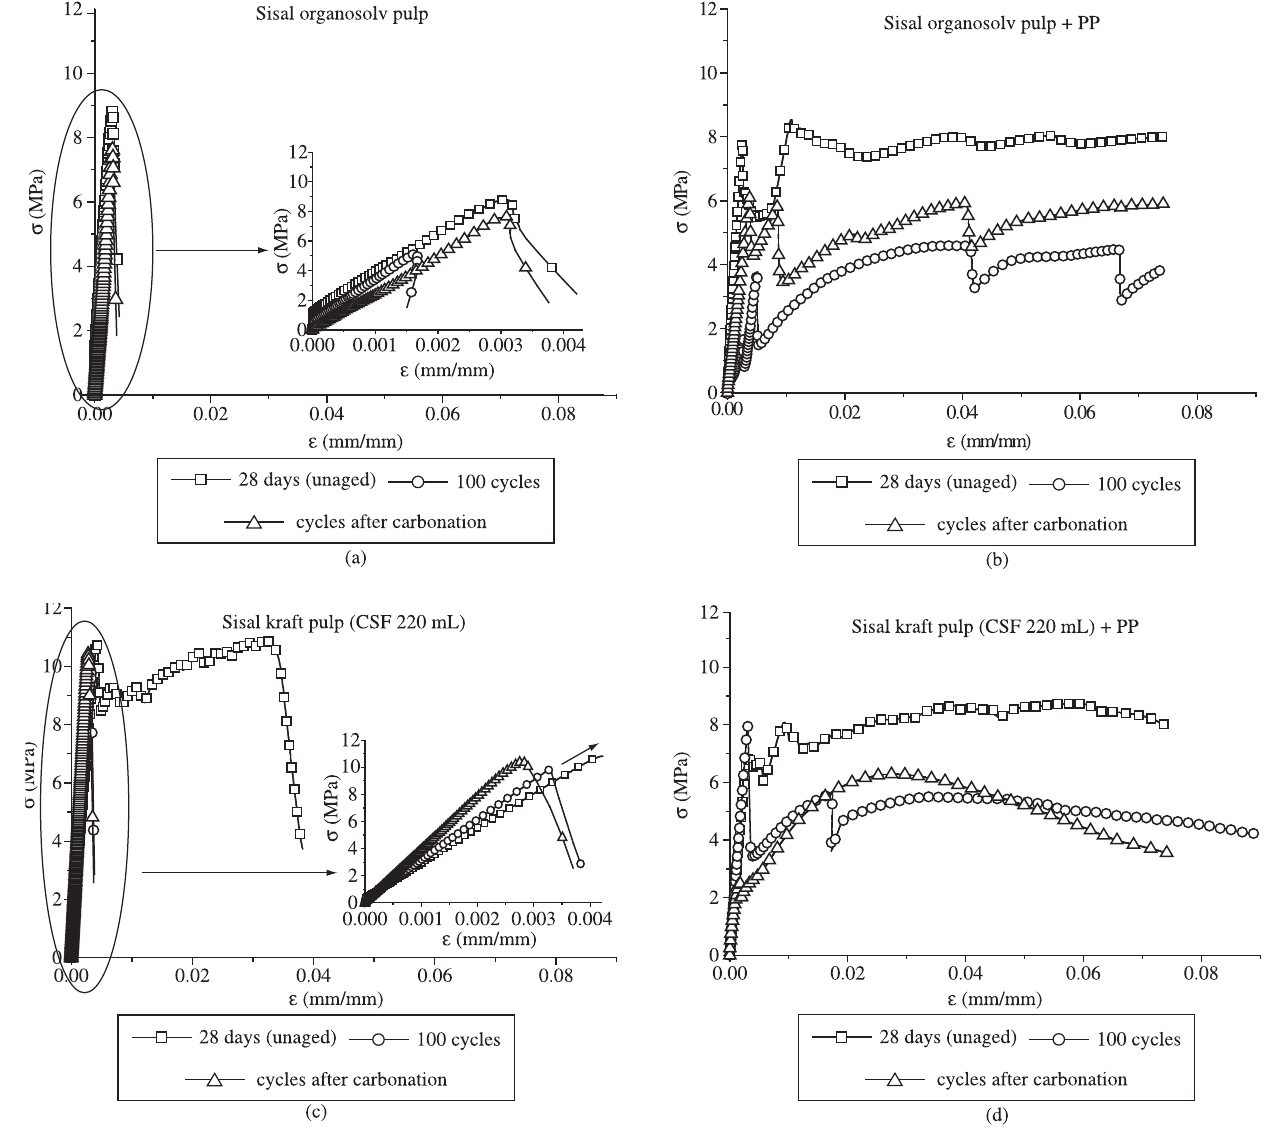
Figure 8. Stress-strain curves for composites with different reinforcing fibres at 28 days and after 100 cycles with/without fast carbonation: a) sisal organosolv pulp; b) sisal organosolv pulp with polypropylene fibres; c) sisal kraft pulp and d) sisal kraft pulp with polypropylene fibres.